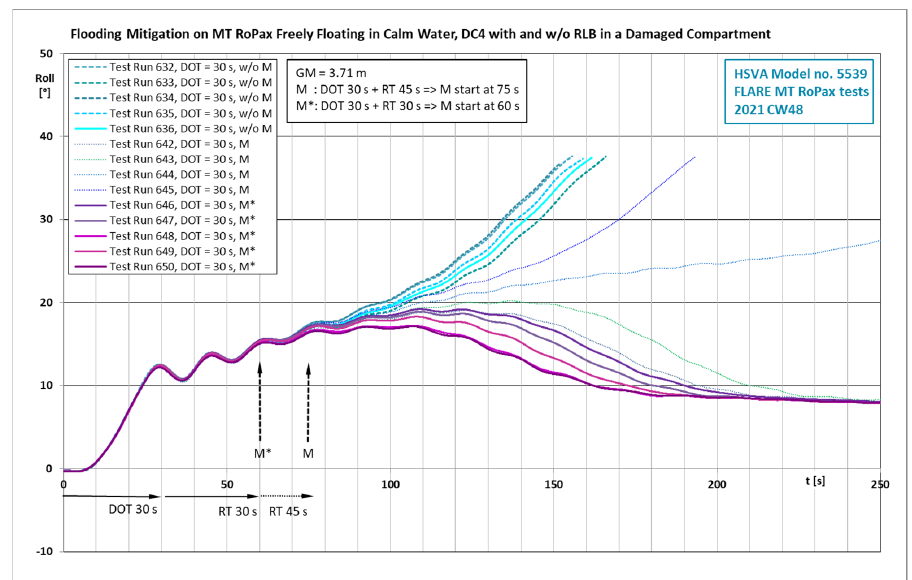
Figure 14. Damage Case 4 with damage opening time 30 s: Roll angle as a function of time with (solid lines) and without (dashed lines) recovery of lost buoyancy in the damaged compartment T045. The dotted curves show cases (‘M’) in which the reaction time 45 s did not in all cases lead to ship survival.